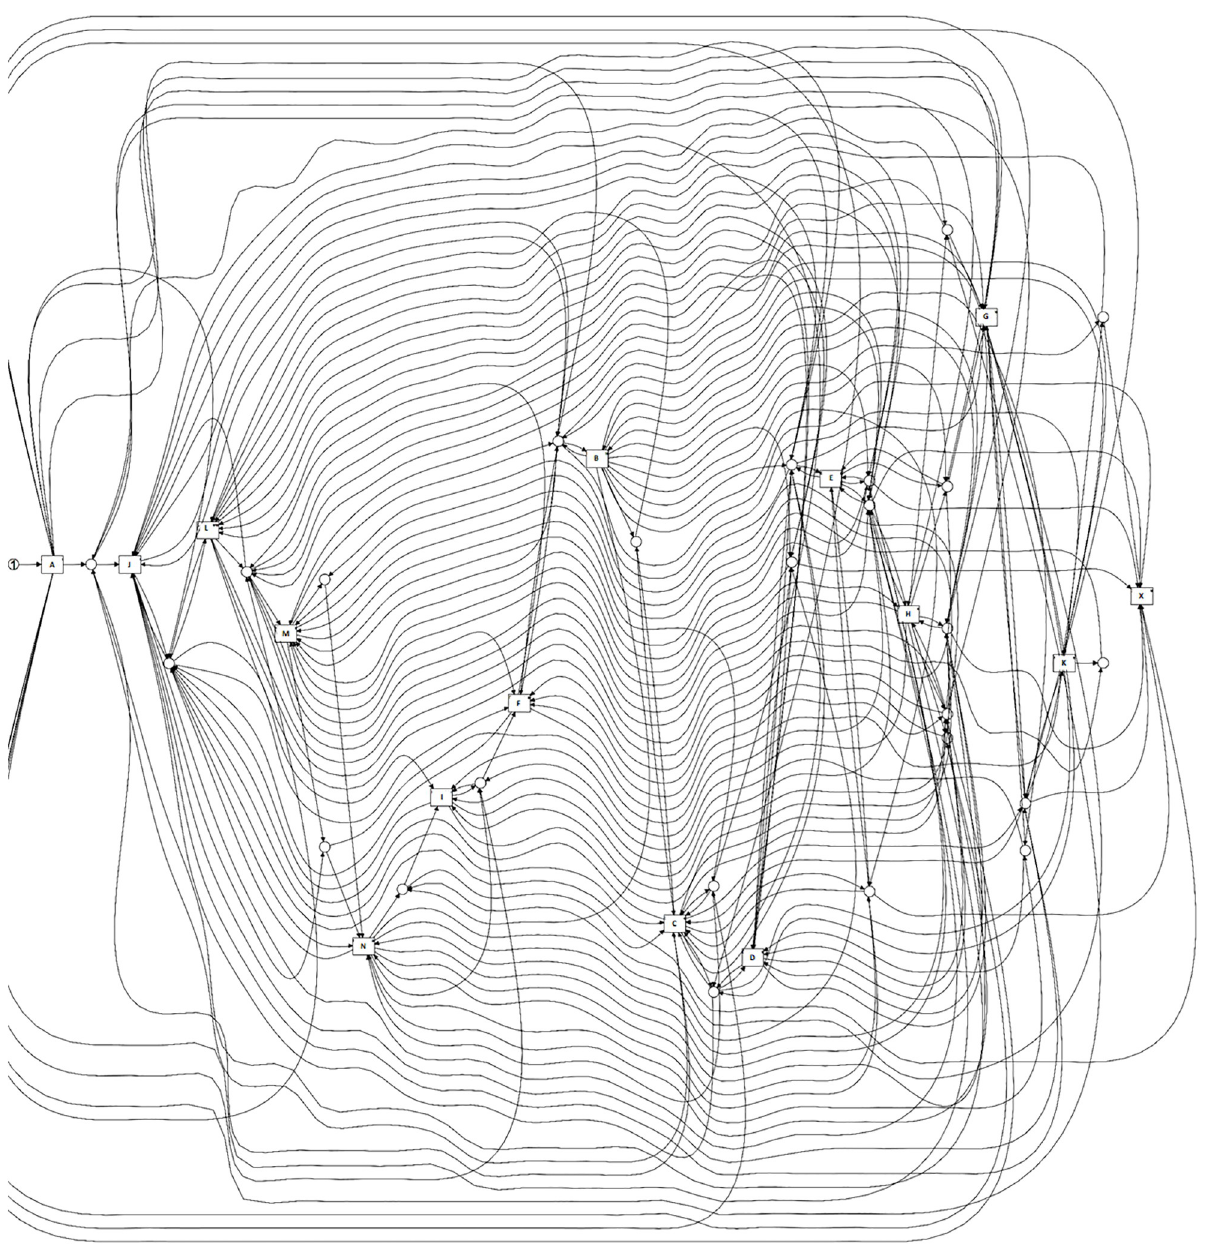
Fig 13. Petri net from the ILP miner.